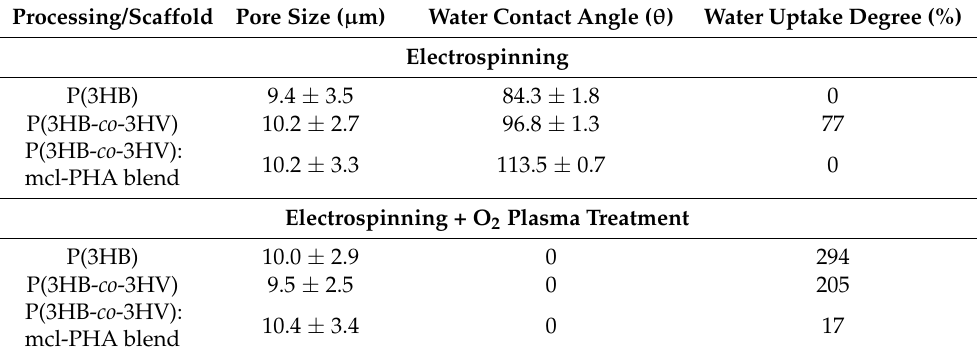
Table 3. Water contact angles and water uptake degree of the scaffolds fabricated with P(3HB), P(3HB-co-3HV) and P(3HB-co-3HV): mcl-PHA blends. Processing/Scaffold Pore Size ( µ